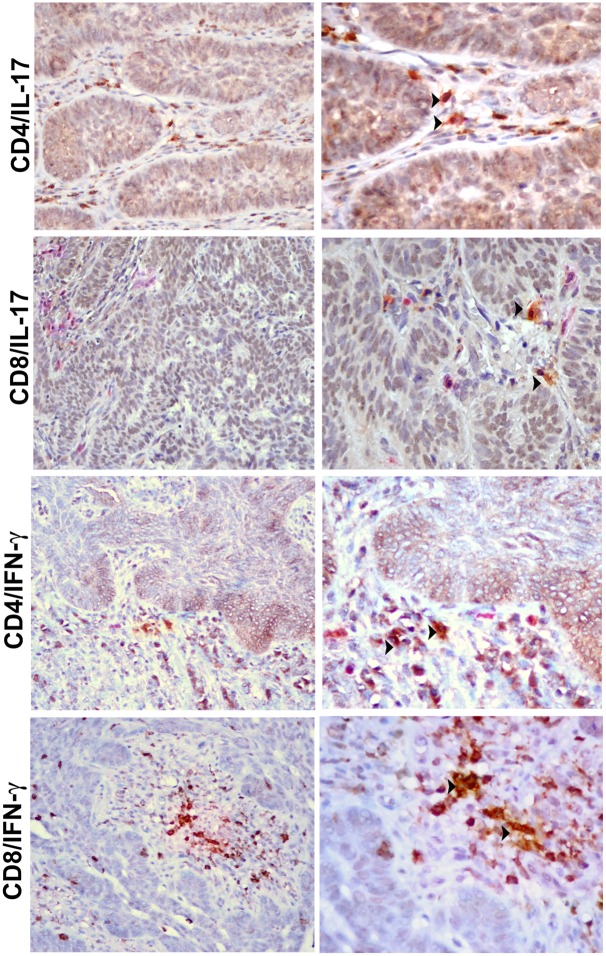
Double staining of IL-17 or IFN-γ with CD4 or CD8.(A) Double-staining of IL-17 (red) and CD4+ (brown) inflammatory cells and (B) of IL-17+ (red) and CD8+ (brown) cells. (C) Double-staining of IFN-γ (red) and CD4+ (brown) inflammatory cells and (D) of IFN-γ (red) and CD8+ (brown) inflammatory cells. Arrowheads indicate double-positive cells. Left panel magnification: 200×; right panel magnification: 400×.